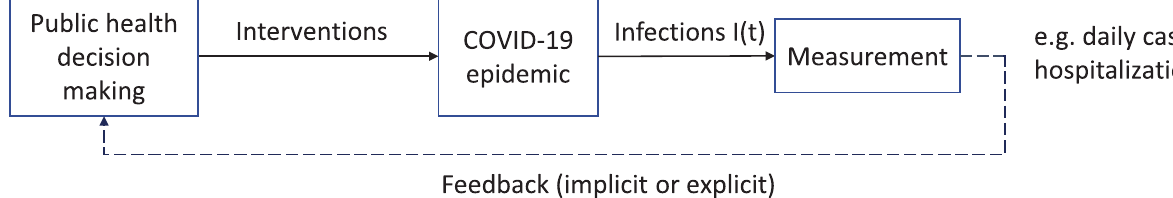
Fig 2. Schematic of public health policy for control of COVID-19 with feedback loop. Public health recommendations that affect COVID-19 infections I ( t ) are made using implicit or explicit feedback from measurements such as reported cases or hospitalizations.